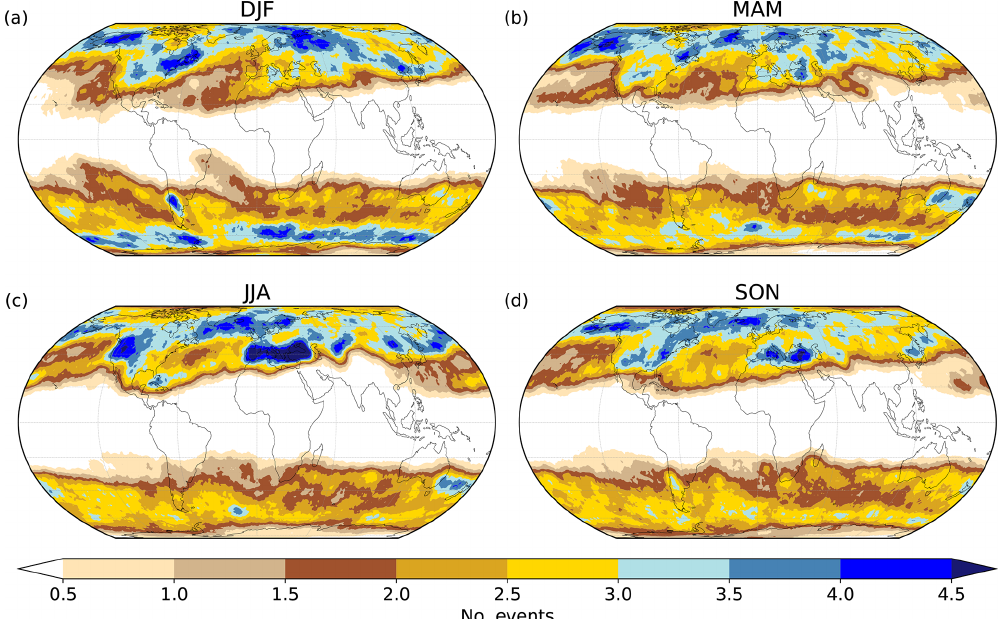
Figure 5. Seasonal average number of PV cutoff lysis events within a distance of 500km in (a) DJF, (b) MAM, (c) JJA, and (d) SON. The location of a lysis event is determined by the center of the last PV cutoff of a